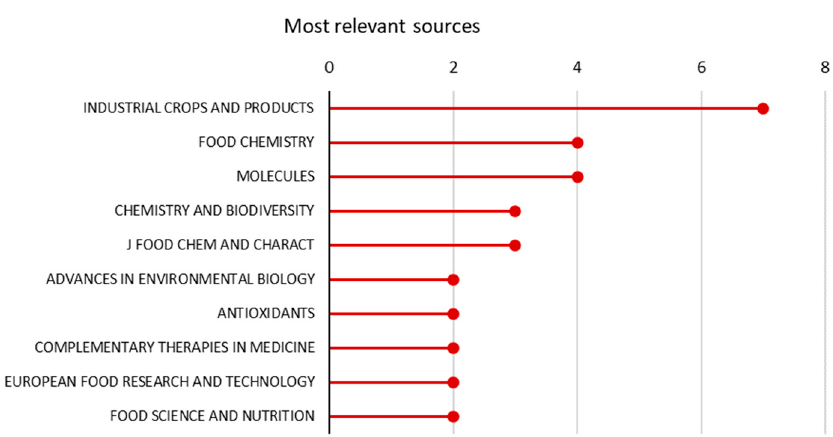
Figure 2. Most relevant journal sources for sumac in terms of number of publication (1993–2002). The total number of unique sources is 148.